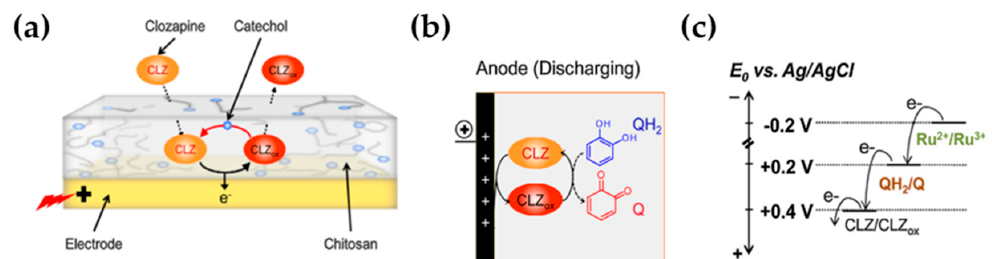
Figure 13. Clozapine (CLZ) as an oxidizing mediator in the catechol-modified chitosan system. ( a ) Schematic of the system with the diffusing CLZ; ( b ) continuous oxidation of CLZ in the presence of catechol (Q) reduction; ( c ) CLZ acts as an oxidizing mediator of QH 2 and Ru 2+ as a reducing mediator regenerating the Q. Electrochemical potential bar represents standard reduction potential of Ru 2+ , Q and CLZ. Reprinted with permission from reference [44]. Copyright © 2015 © 2014 Elsevier, Ltd.